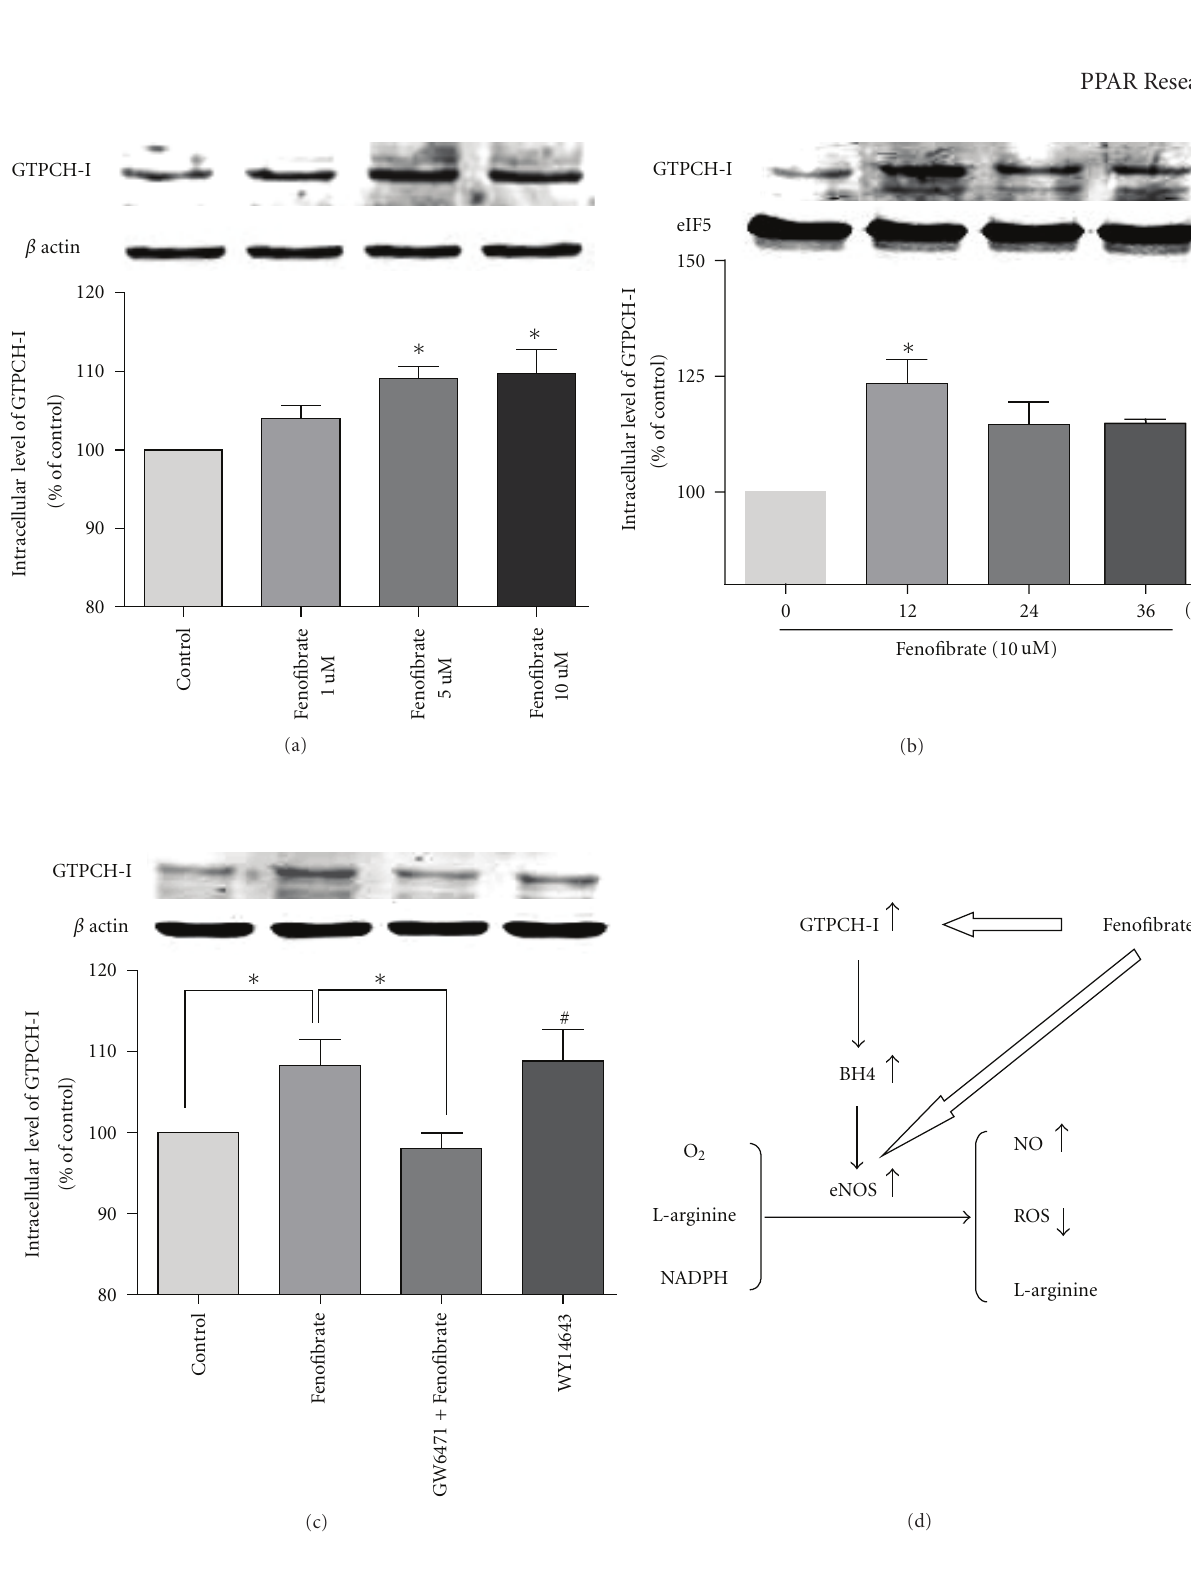
Figure 4: Fenofibrate increases GTPCH-I protein levels in HUVECs, as demonstrated by Western blot analyses. (a) Cells were treated for 24h with increasing concentrations of fenofibrate. (b) The level of GTPCH-I after fenofibrate treatment reached maximum at 12 hours and maintained a high level for a long time. (c) GW6471 antagonizes fenofibrate-induced increase in GTPCH-I protein level, WY14643 increases GTPCH-I protein level similarly to the e ff ect of fenofibrate. Dates are means ± SD in three experiments. (a, b): ∗ P < 0 . 05 versus control group; (c) ∗ P < 0 . 05, # P < 0 . 05 versus control group. (d) Proposed scheme: Fenofibrate not only promotes the expression of eNOS, but also up-regulates the level of GTPCH-I, contributing to the increase of BH4, which could promote the activity of eNOS, thus resulting the increase of NO and decrease of